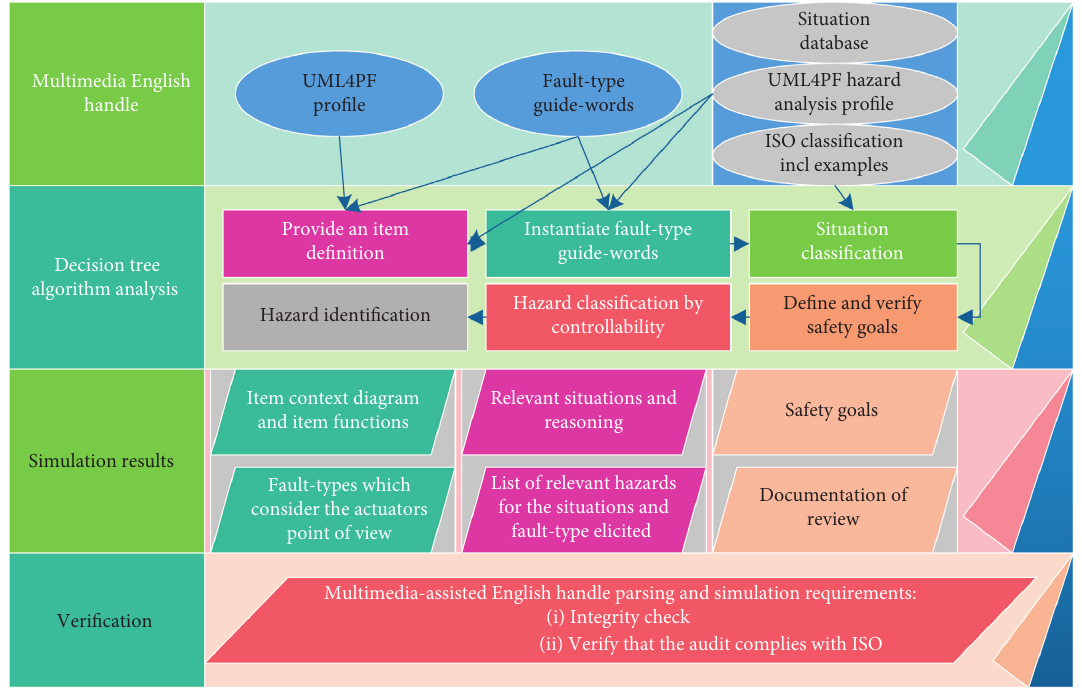
Figure 4: Analysis and simulation evaluation design.